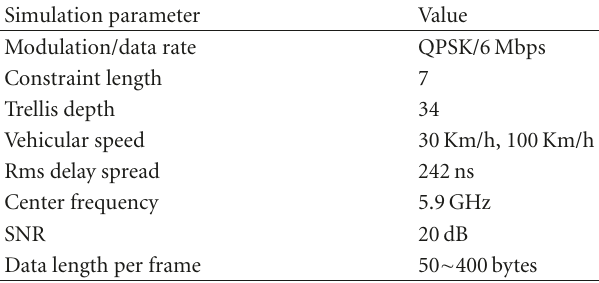
Table 3: Simulation parameters for channel estimation perfor-